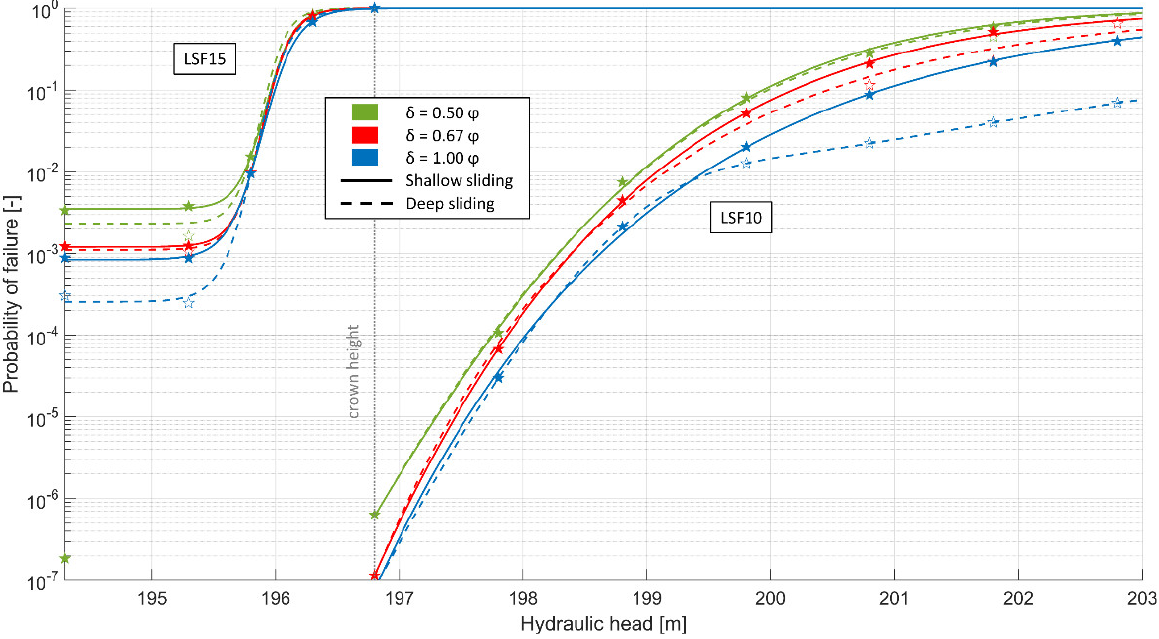
Figure 9. Diagrams shown in logarithmic scale.